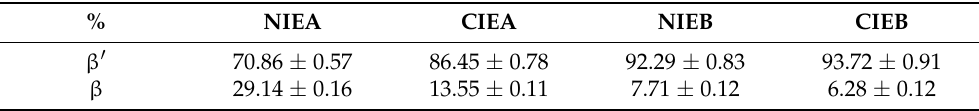
Figure 5. XRD spectra of samples before and after interesterification. Table 4. Polymorphic forms (%) of crystals of